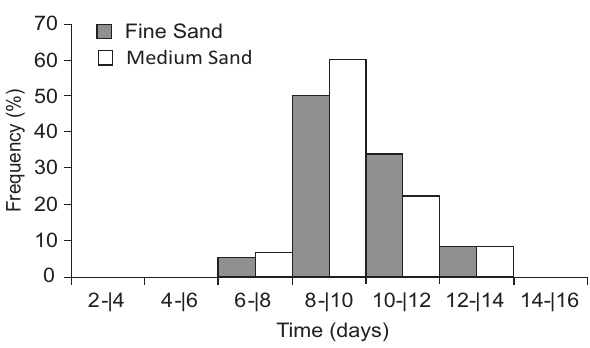
Figure 2. Time between laying the cocoon and eclosion of Limnodrilus hoffmeisteri cultivated in medium sand (0.250-1.000 mm) and fine sand (0.057-0.250 mm) at 25 ± 1°C.